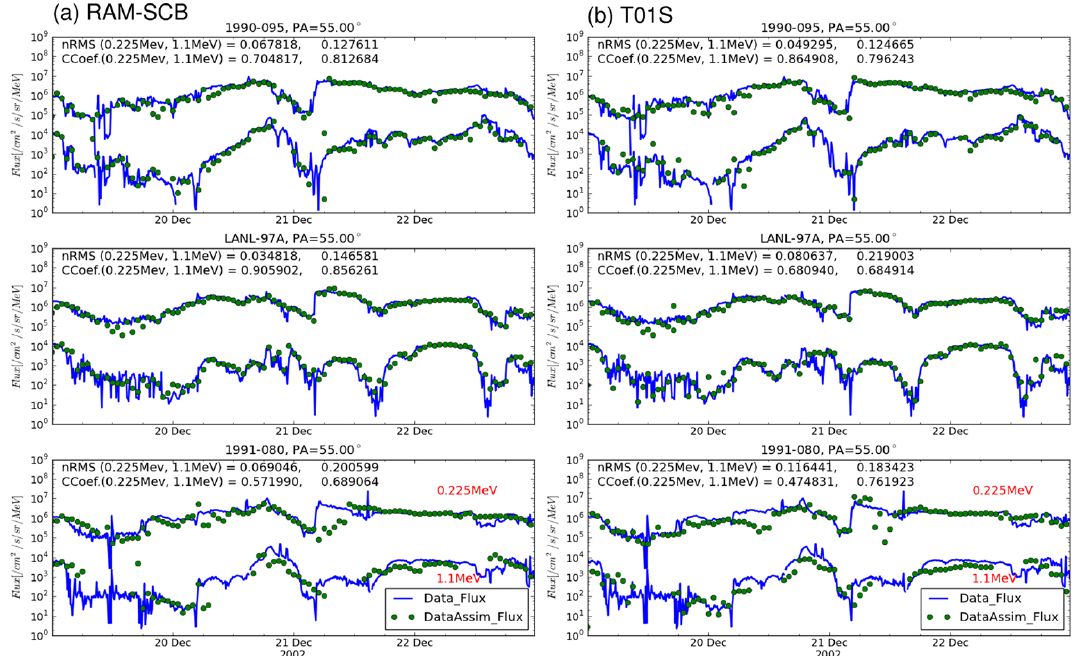
Fig. 5. The predicted flux (green) from the assimilated radiation environment along three LANL-GEO satellite trajectories, compared to original flux observations (blue). The nRMS error and cross-correlation coefficients are denoted for each comparison. The top two rows are along the satellites that provided the input PSD data to the data assimilation, while the bottom row is from an independent trajectory. The left column shows the flux comparison from the data assimilation using the RAM-SCB magnetic field configuration, and the right column is the comparison from the data assimilation using the T01S magnetic field model.